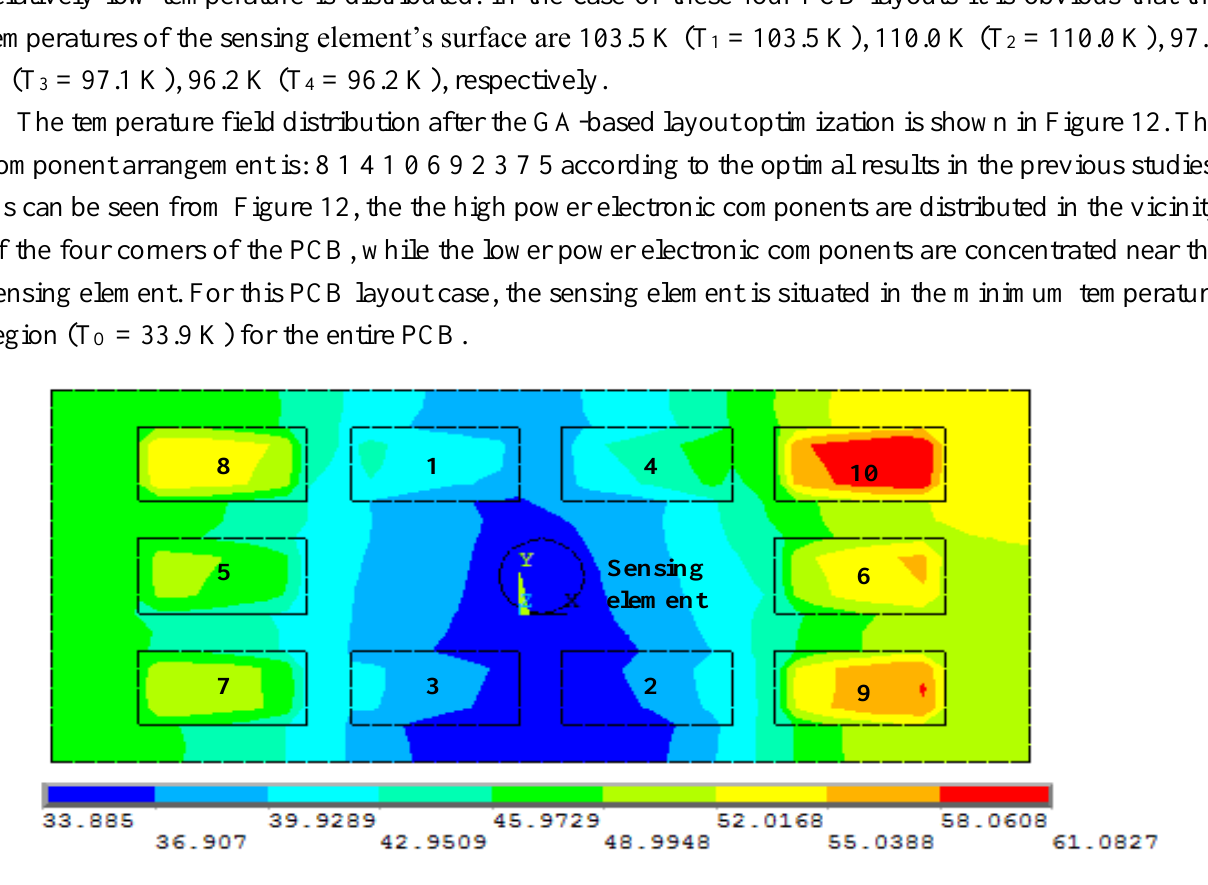
Figure 12. The temperature field distribution after layout